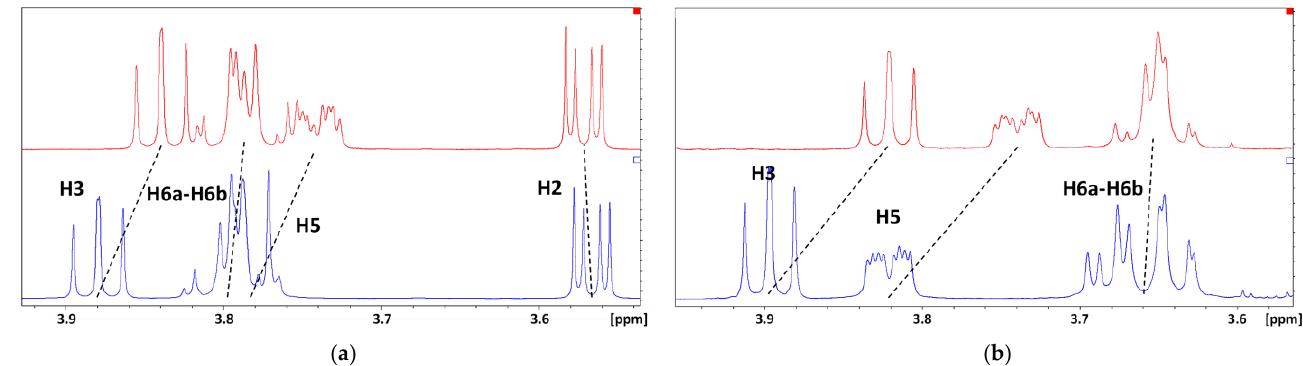
Figure 4. Stacking of partial 1 H NMR (600 MHz, 298 K) spectra of ( a ) 3 mM βCD (0.1 M acetate -buffered D 2 O) and ( b ) 2 mM DIMEB (13 mM HCl in D 2 O) in the absence ( ) or presence of an equimolar concentration of carvedilol ( ).